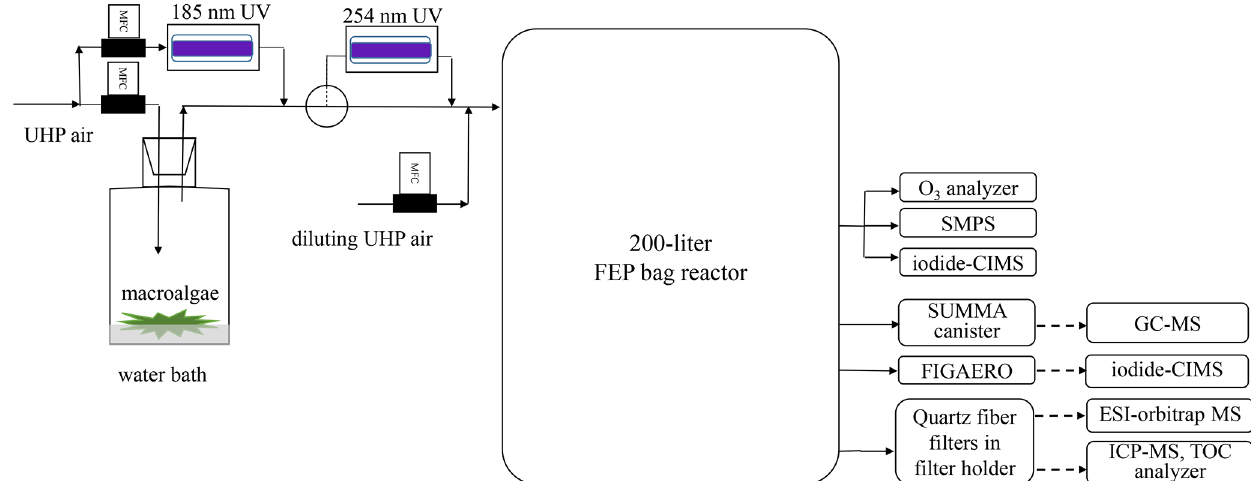
Figure 1. Schematic of experimental setup. Solid line: air flows. Dashed lines: sent for offline chemical analysis.